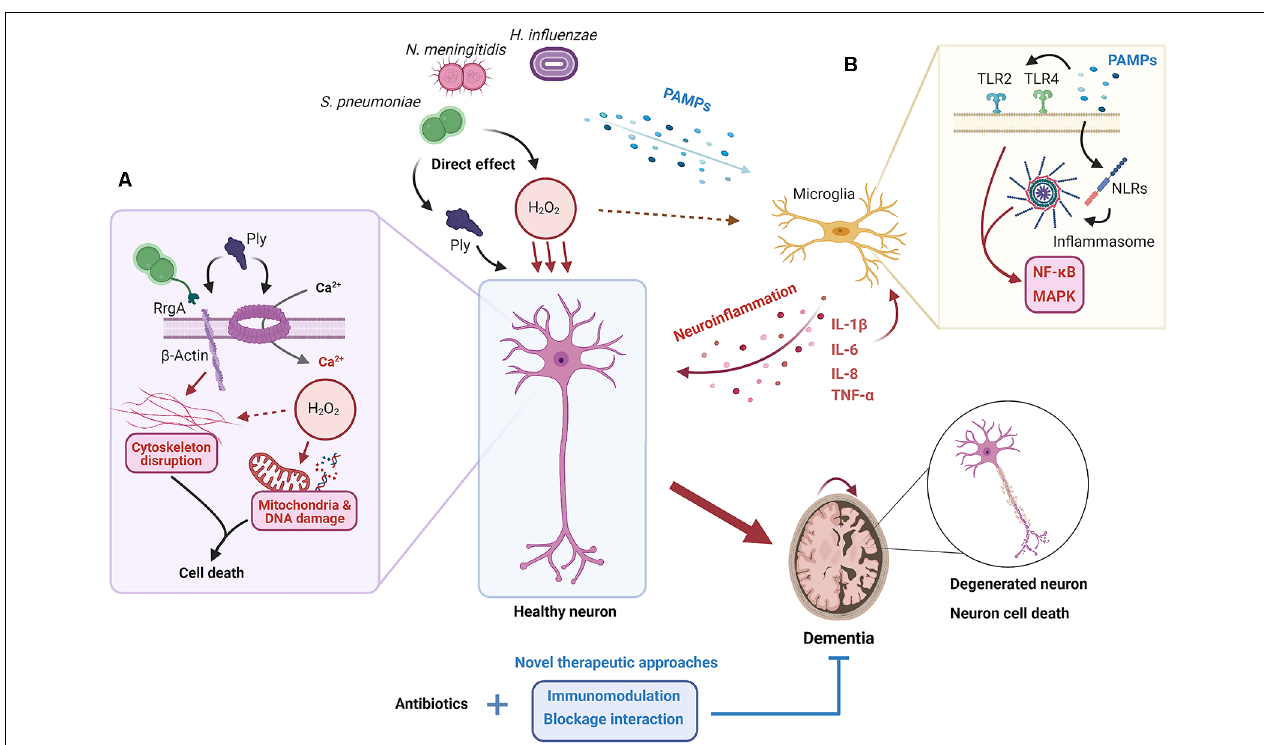
FIGURE 1 | Proposed mechanisms for neuronal damage during bacterial meningitis. When the pathogens S. pneumoniae , N. meningitidis , and H. influenzae invade the brain, both the action of their virulence factors and the elicited neuroinflammatory response cause neuronal damage and death. (A) Pores in the neuron plasma membrane formed by pneumolysin (Ply), released by S. pneumoniae , result in the influx of extracellular Ca 2+ . At the same time, the interaction between β -actin, exposed outside the plasma membrane, with Ply and RrgA causes the disruption of the actin cytoskeleton. This, coupled with the release of H 2 O 2 , oxidative outburst, and subsequent mitochondrial and DNA damage, results in neuronal death. (B) Several pathogen-associated molecular patterns (PAMPs) are recognized by microglia through receptors such as TLRs and NLRs, which results in the activation of nuclear factor (NF)- κ B and the mitogen-activated protein kinase (MAPK) pathway and the release of pro-inflammatory cytokines and other mediators, and the recruitment of inflammatory cells. The establishment of a neuroinflammatory state inside the brain leads to neuronal death through different mechanisms such as tumor necrosis factor (TNF)- α overproduction or oxidative outburst. Ultimately, neuronal death results in neurological sequelae and potential long-term dementia; something that may be prevented if current antibiotic treatments are coupled with new therapeutic approaches based on immunomodulation and/or blockage of direct interaction between bacteria and